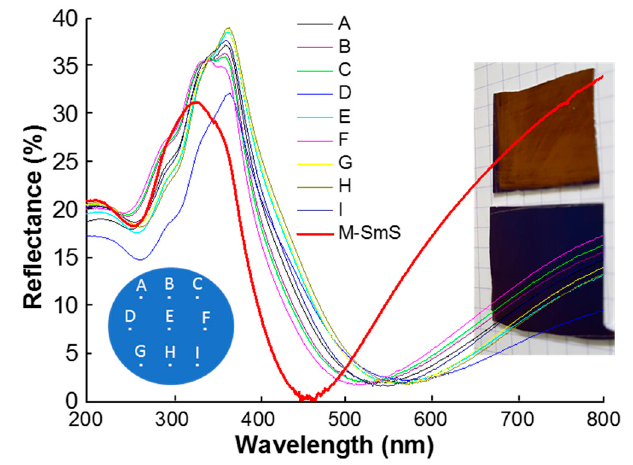
Figure 4. Optical reflectance from several spots on a 150 mm Si (100) wafer, on which 100 nm of SmS was deposited (substrate temperature of 250 °C). The scheme on the bottom left shows the location on the wafer for the respective reflection spectra. The photographs show the appearance of the as-deposited thin film (bottom) having a bluish-navy color and in the metallic state after rubbing (top), featuring a goldish color. The reflection spectrum of the latter (for position E), is indicated by “M-SmS”.